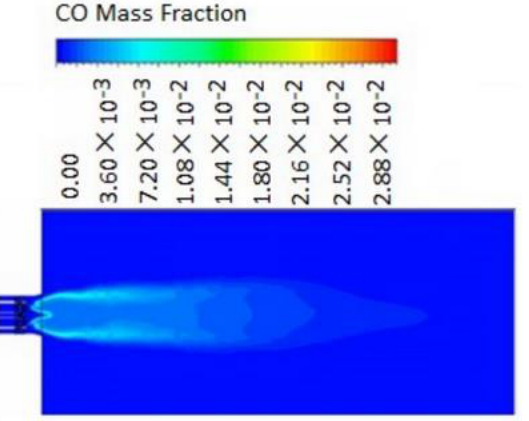
Figure 9. Building a mathematical model of the carbon oxide distribution based on the data collected by the neural network.